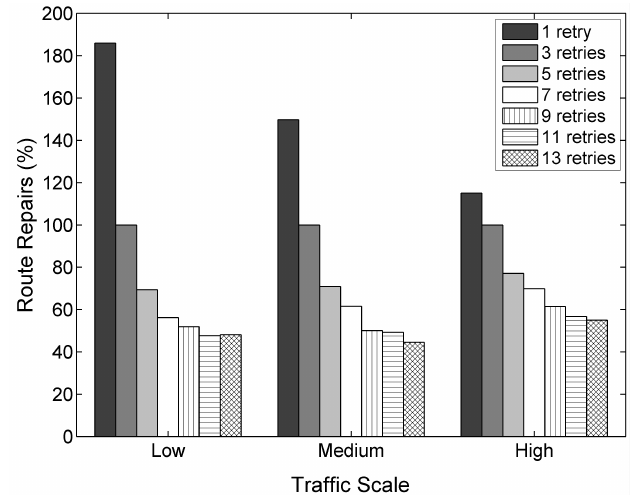
Figure 9. Relative amount of route repairs for different values of macMaxFrameRetries taking the default value of three as the